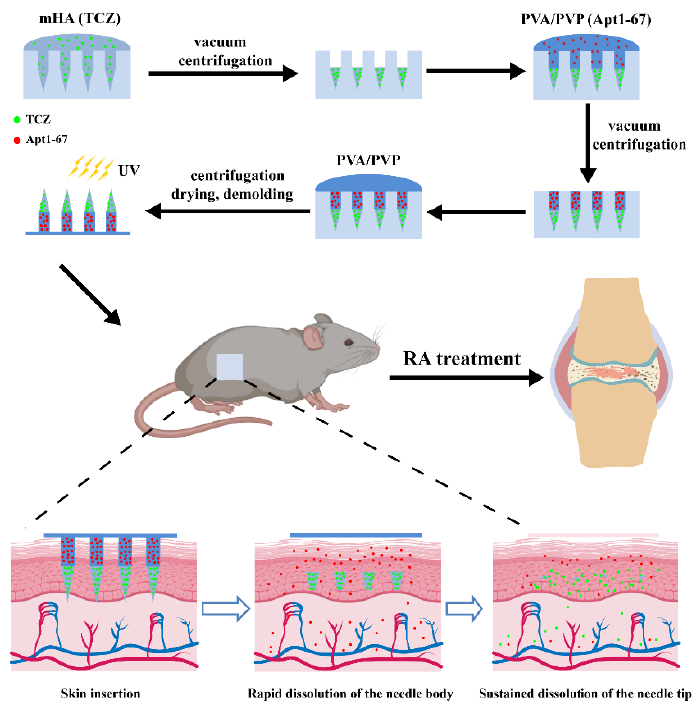
Figure 1. Schematic illustration of the preparation and the possible anti-RA activity of the dual-drug loaded separable MN in vivo. TCZ and Apt1-67 were loaded in the needle tips and needle bodies, respectively. After application of TCZ/Apt1-67@MN, the rapid dissolution of the needle bodies leads to the fast release of Apt1-67, while the slow dissolution of the needle tips enables a sustained release of TCZ. The released drugs directly enter into the blood circulation, resulting in a combined medication of Apt1-67 and TCZ for efficient RA therapy.